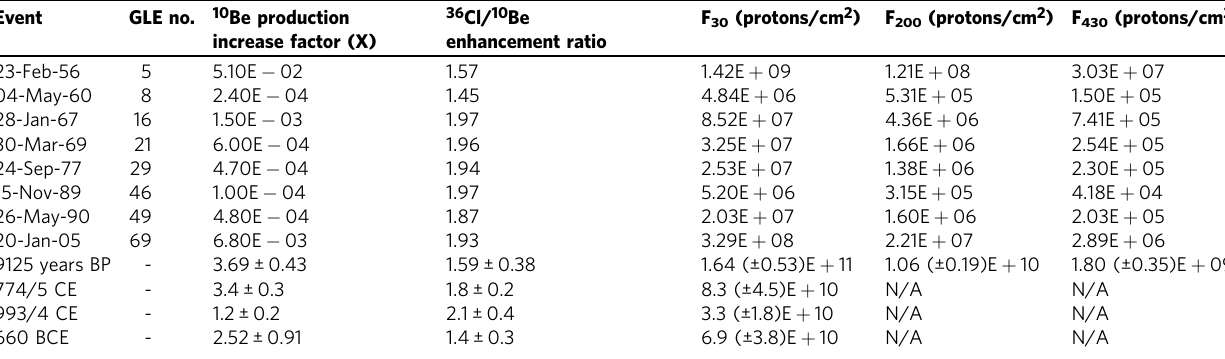
Table 2 Information about the modern GLEs with spectral shapes agreeing with the 36 Cl/ 10 Be ratio for the 9125 years BP event: the 10 Be production increase factor of each reference GLE relative to the GCR baseline for Φ = 650 MV, fl uences (protons/cm 2 ) above 30, 200 and 430 MeV 8,9